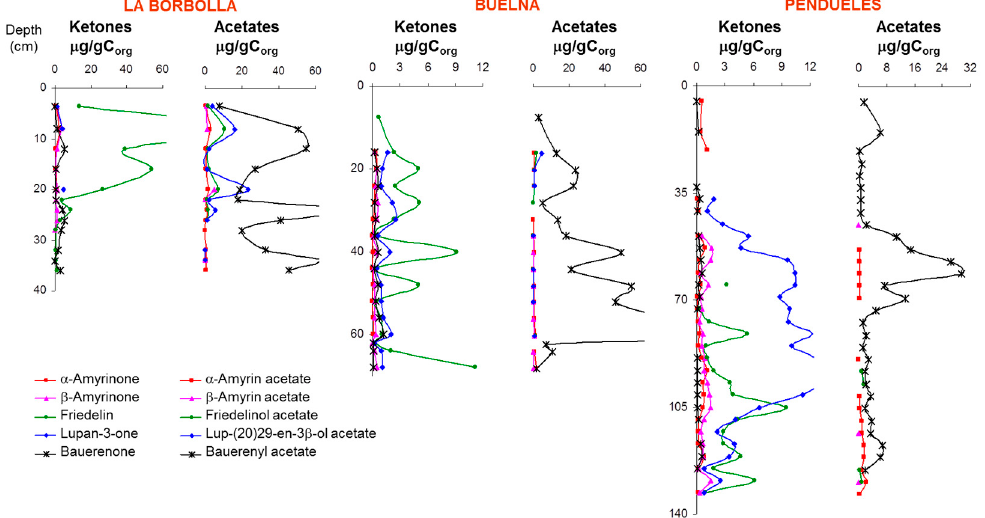
Figure 5. Variation of the concentration of higher plant triterpenoid ketones and acetates in the Buelna, La Borbolla, and Pendueles profiles ( μ g/g Corg).